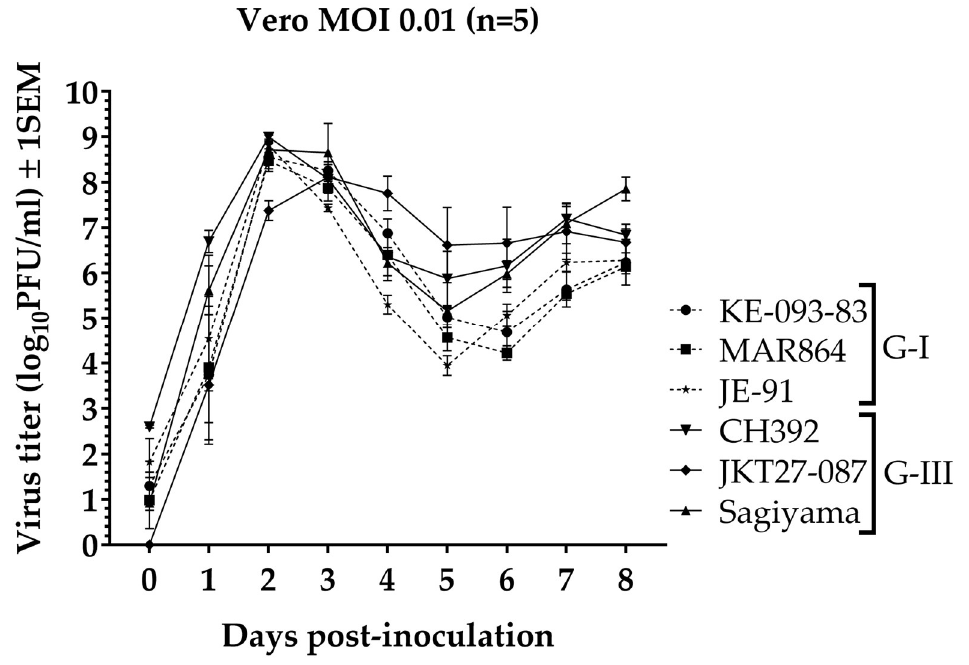
Figure 1. Growth curve of Japanese encephalitis virus G-I and G-III strains in Vero cells.